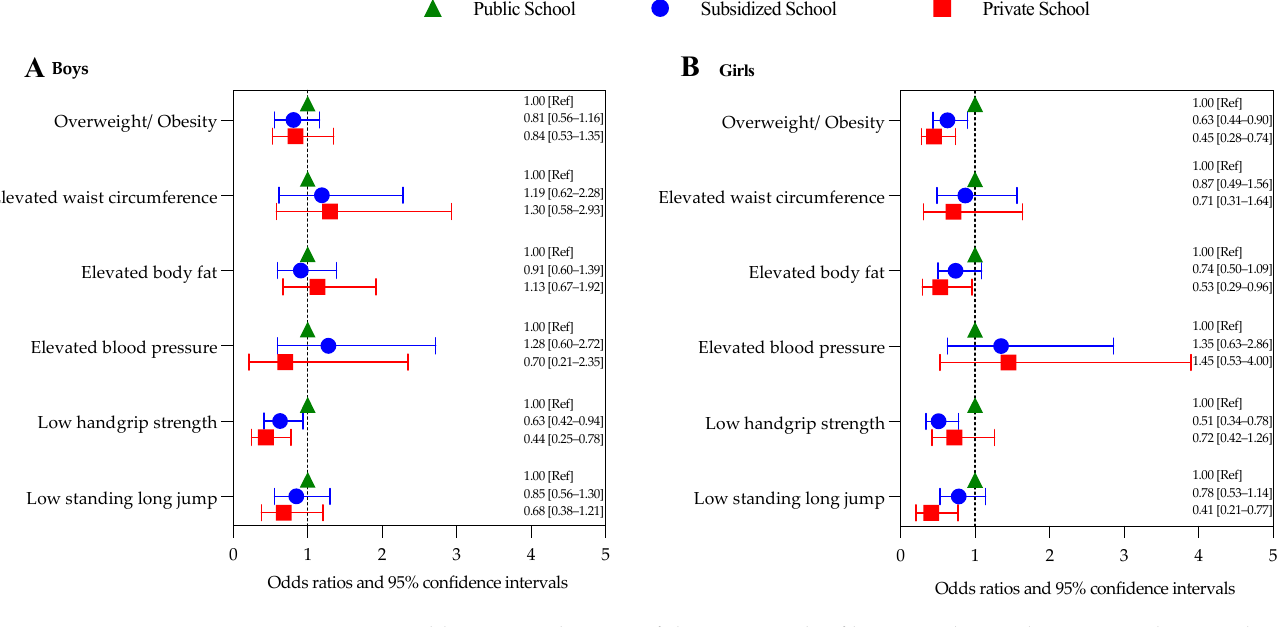
Figure 1. Odds ratios and 95% confidence intervals of having risky conditions according to school type in ( A ) boys, and ( B ) girls. Models for overweight/obesity and elevated body fat were adjusted for age; all other models were adjusted for age and body mass index Z-score. Ref, reference.